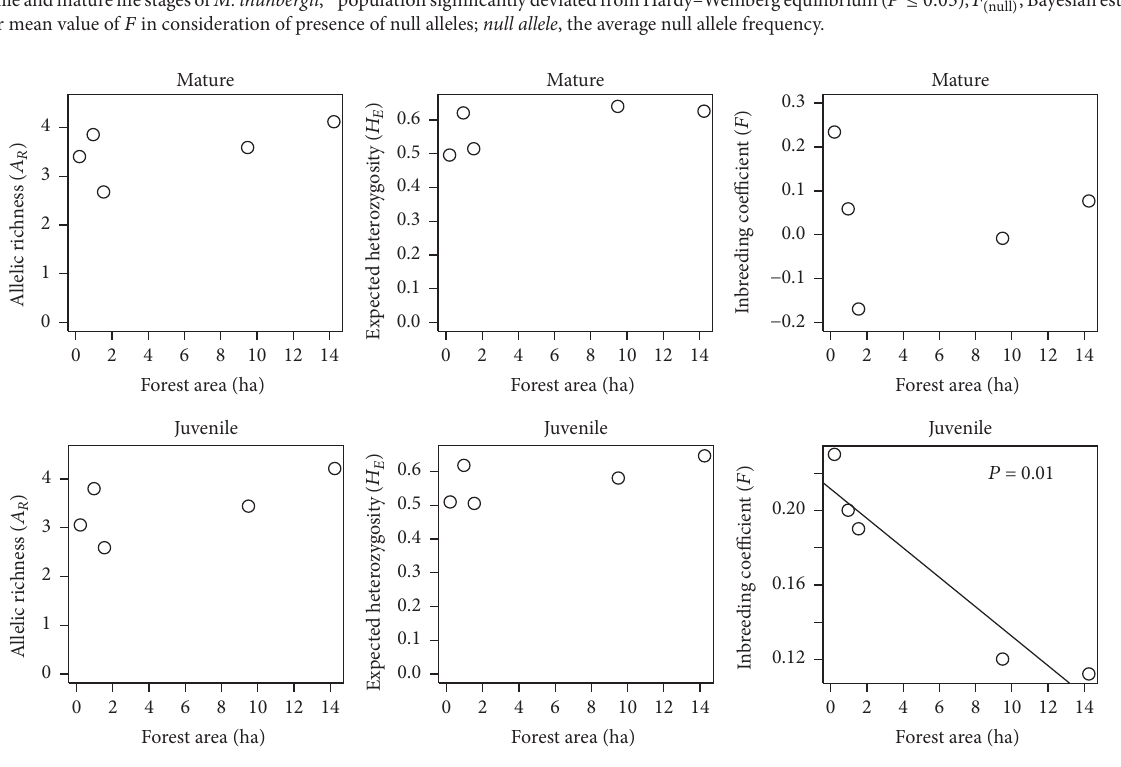
Figure 2: Relationships between the genetic diversity parameters ( 𝐴 𝑅 , 𝐻 𝐸 , 𝐹 ) and forest area in mature and juvenile Machilus thunbergii